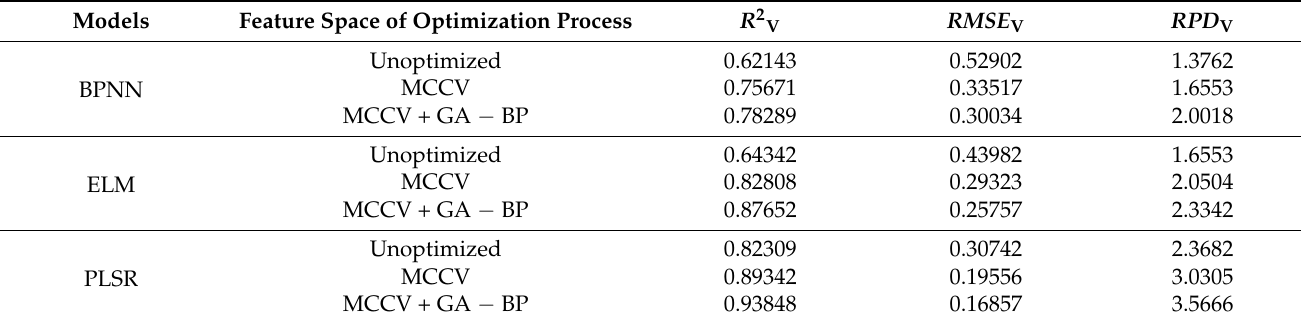
Table 5. Test set